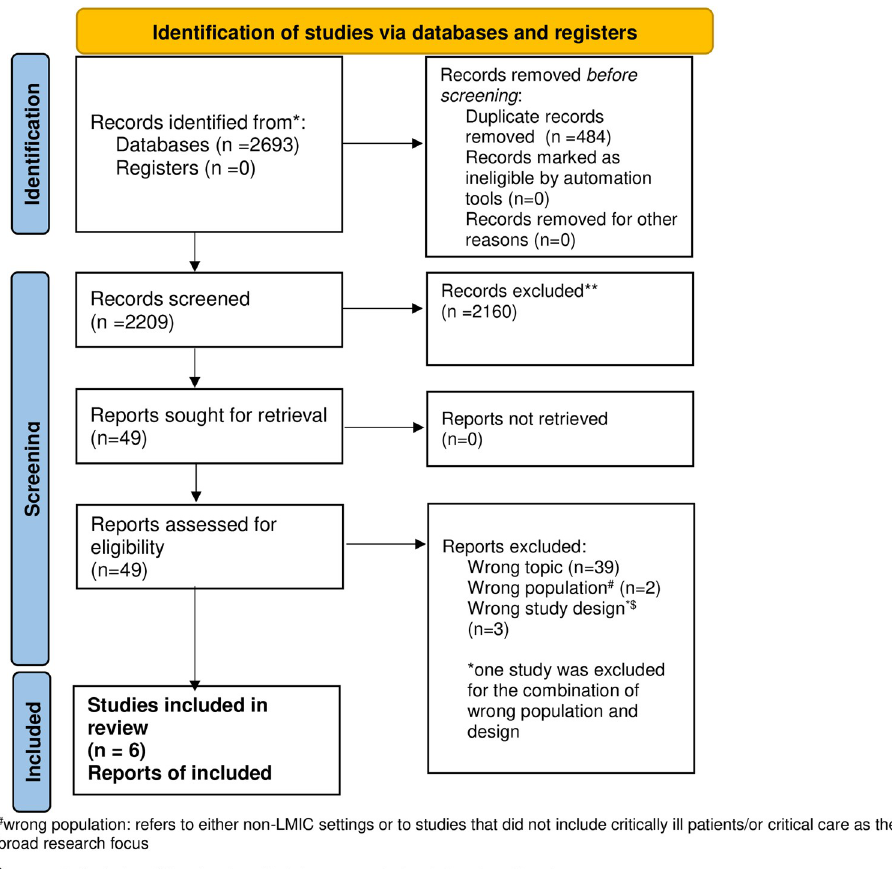
Fig 1. PRISMA 2020 flow diagram for new systematic reviews which included searches of databases and registers only.